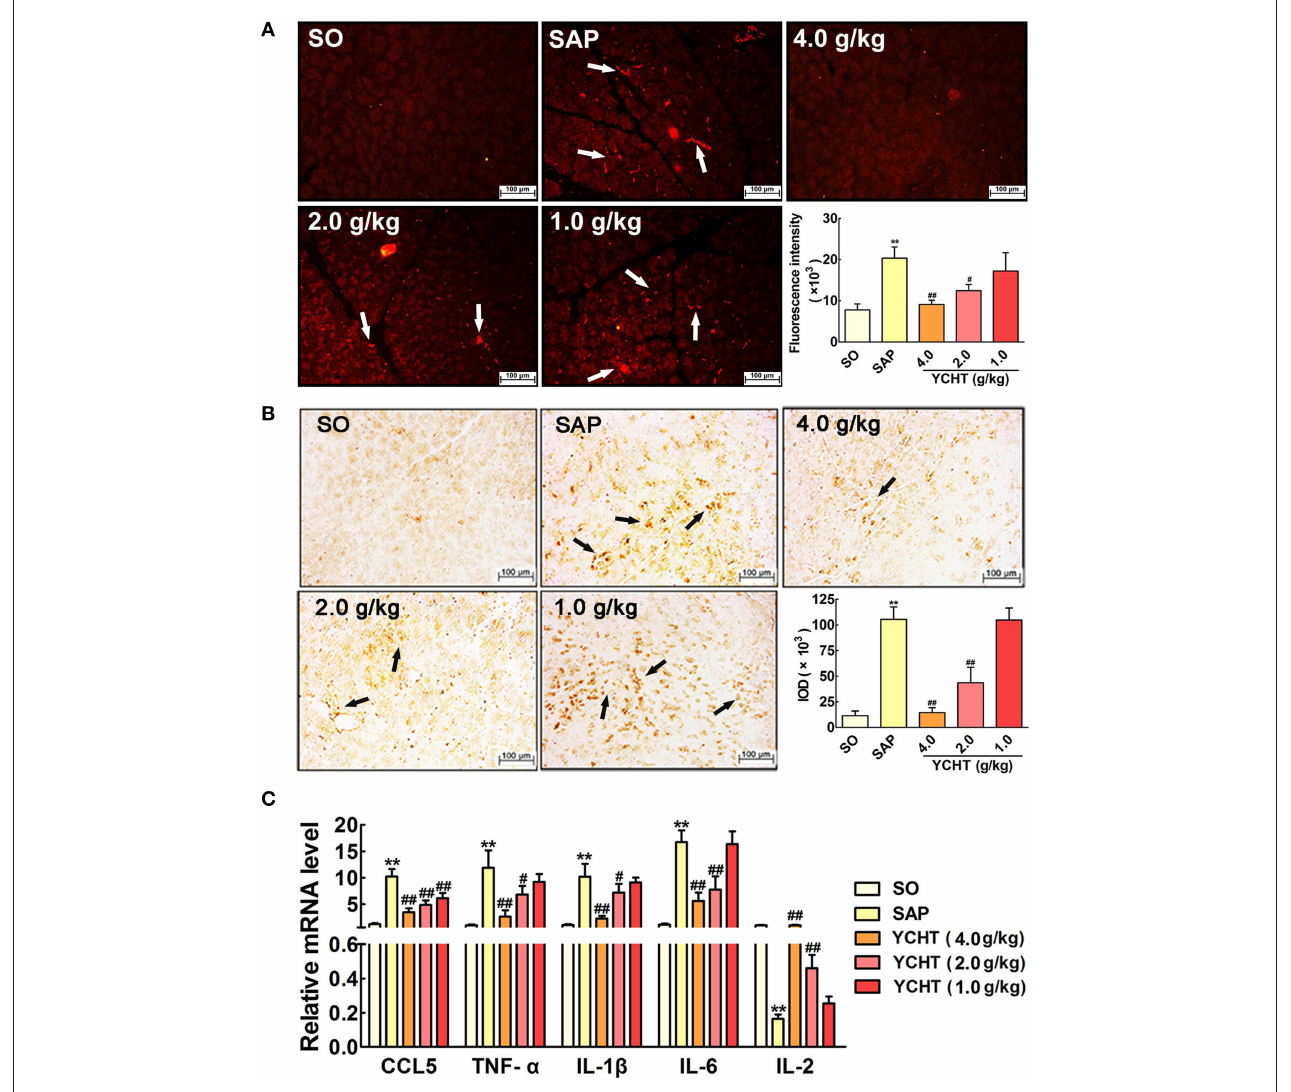
FIGURE 6 | Yin-Chen-Hao Tang reduced neutrophil infiltration and inflammatory mediator release in SAP rats. (A) Effects of YCHT on MPO-immunopositive (red) staining area of pancreatic tissue in SAP rats using immunofluorescence detection ( n = 6). (B) Effects of YCHT on MPO-immunopositive (brown) staining area of pancreatic tissue in SAP rats using immunohistochemical detection ( n = 6). (C) Effects of YCHT on the inflammatory mediators CCL5, TNF- α , IL-1 β , IL-6 and IL-2 mRNA levels of SAP rats ( n = 3). Images are presented at 200 × magnification. The data are presented as the mean ± SD, ∗∗ P < 0.01 versus SO; # P < 0.05 versus SAP, ## P < 0.01 versus